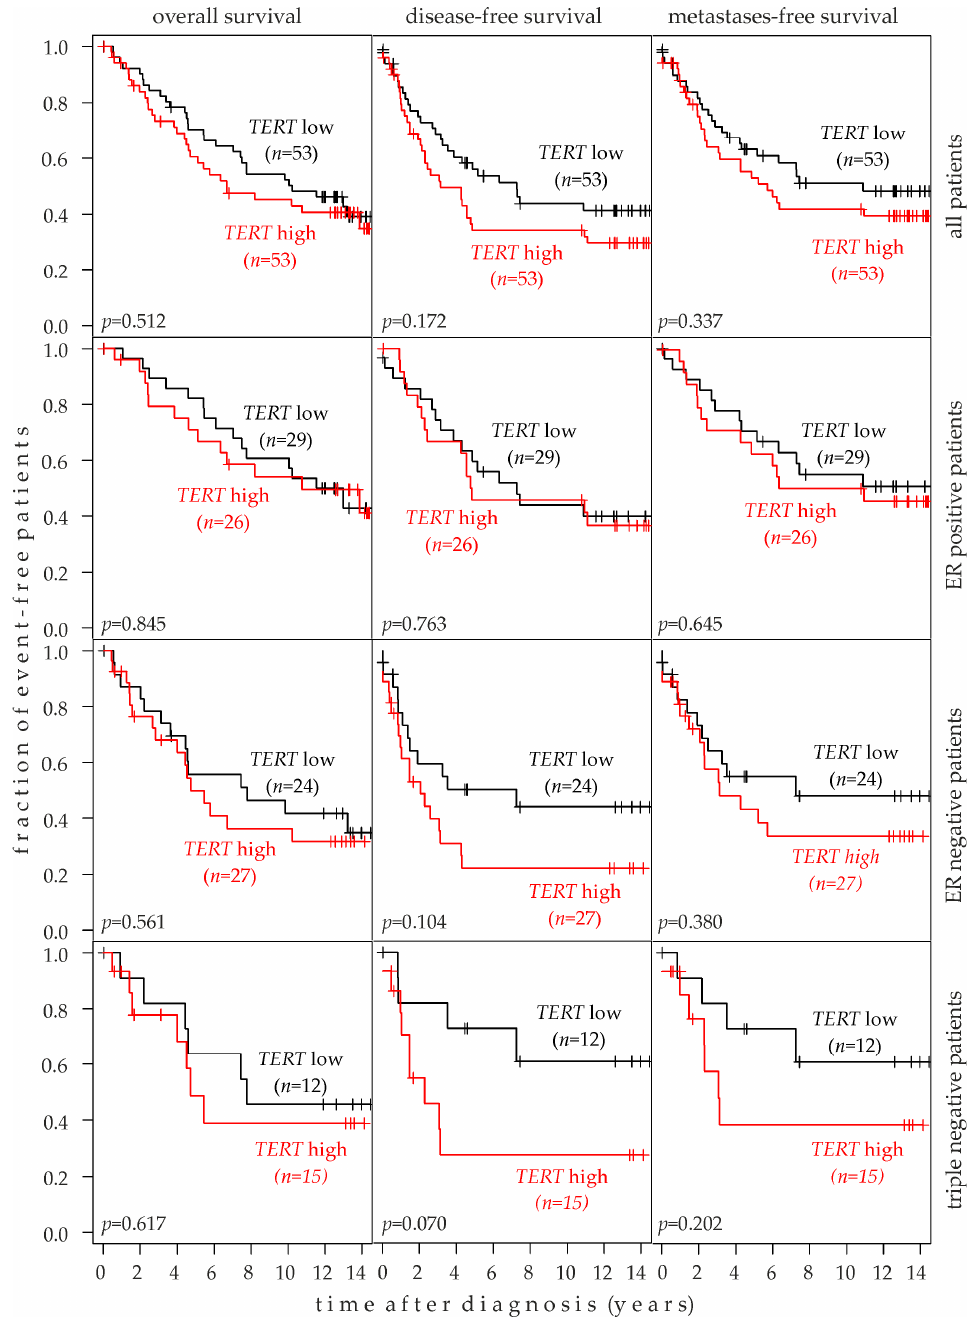
Figure 5. Association of TERT mRNA expression with the survival of human breast cancer patients. Kaplan-Meier analyses of the overall survival, disease-free survival, and metastasis-free survival in unselected patients (top row, n = 106), estrogen receptor (ER) positive patients (second row; n = 55), ER-negative patients (third row; n = 51), and triple-negative patients (bottom row; n = 27) are shown. TERT high, TERT expression above the median of the study population ( n = 106); TERT low, TERT expression below the median.